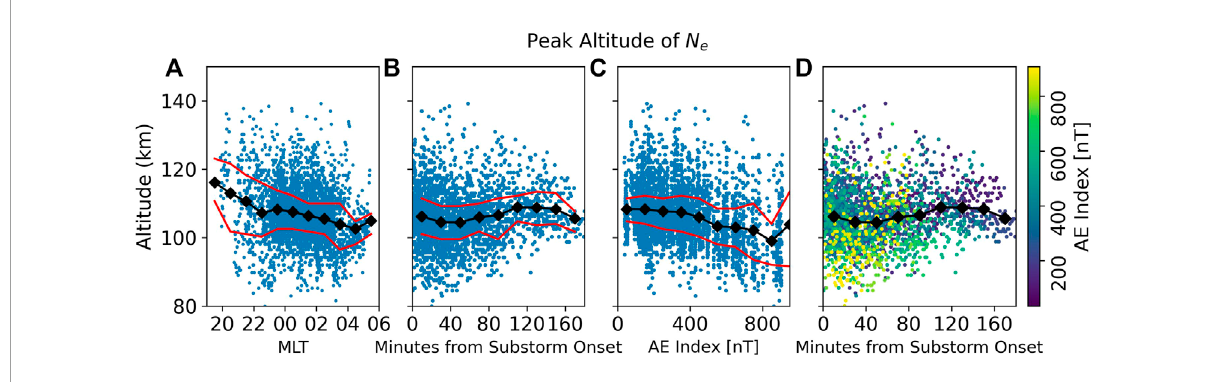
FIGURE 3 Altitude of the peak electron density in PFISR measurements during pulsating aurora plotted versus magnetic local time (A) , time from the nearest substorm onset (B) , AE index (C) , and combined substorm and AE (D) . The black diamonds indicate the average altitude for the surrounding hour, 20 min, 200 nT of AE, and 20 min respectively. The red lines indicate the 25% and 75%